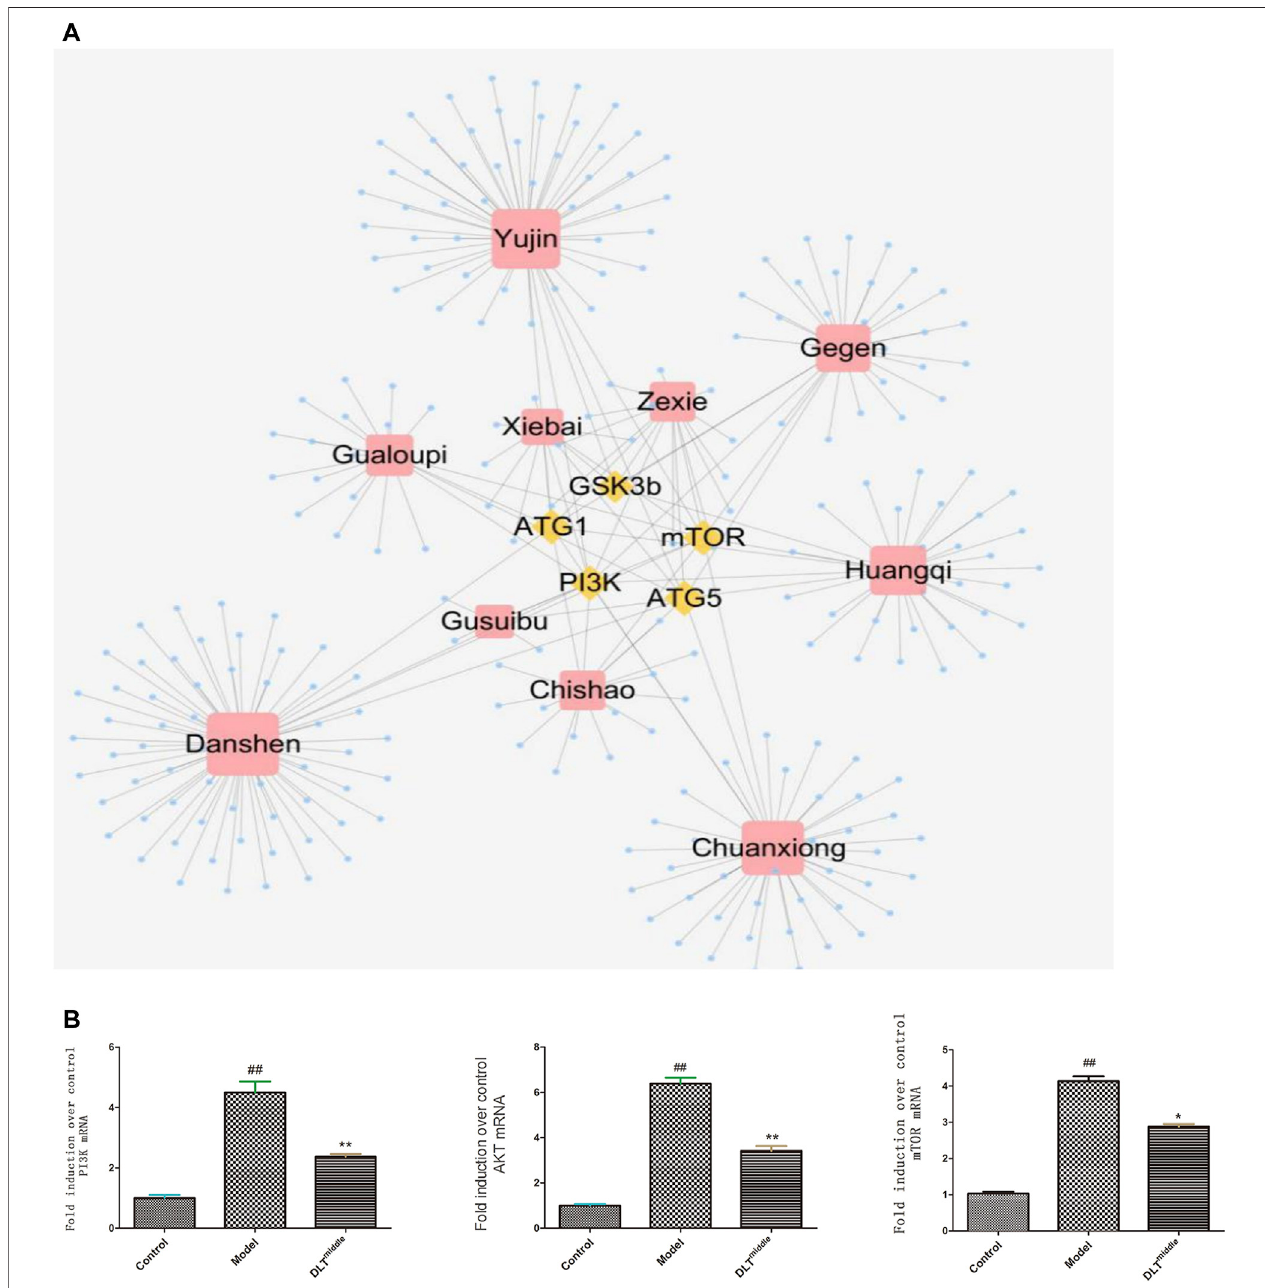
FIGURE 5 | DLTs regulated autophagy through the PI3K/Akt/mTOR signaling pathway in AS APOE - / - mice. (A) Compound-target network for DLTs. The yellow nodes represent potential autophagy-related targets, and the blue nodes represent active compounds. (B) mRNA expression of PI3K/AKT/mTOR in aorta tissues. The data are presented as the mean ± SD ( n (cid:2) 3). ## p < 0.01 vs the control group, and * p < 0.05, ** p < 0.01 vs the model group.